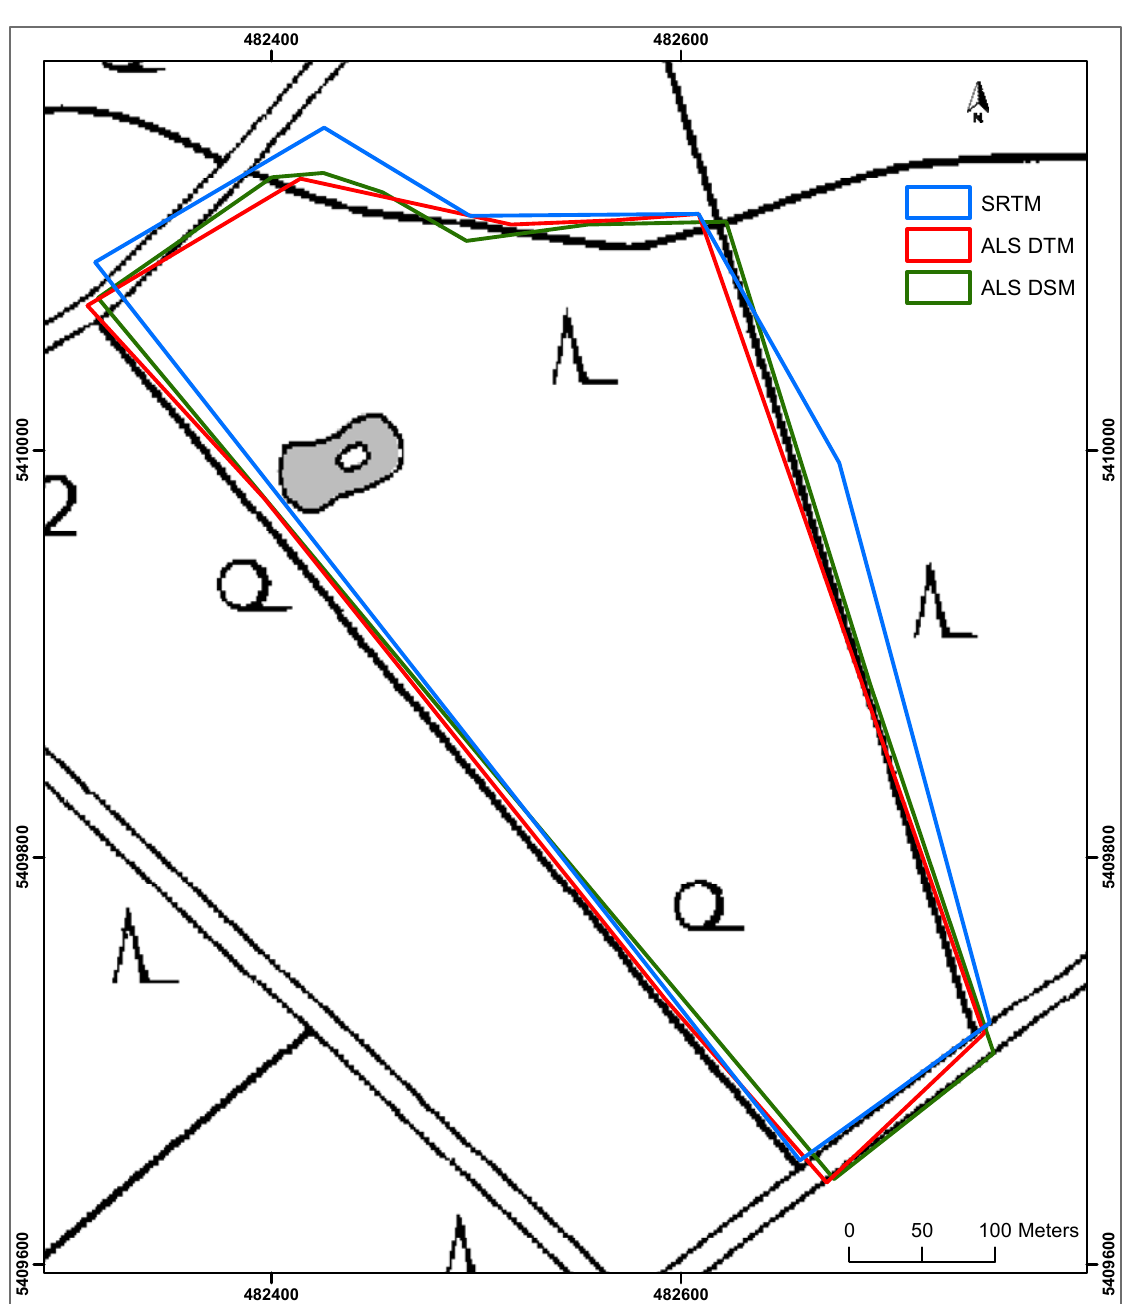
Figure 2. Boundary of a forest stand located in Pforzheim, digitized from three different orthorectified TerraSAR-X images in leaf-off conditions. The official digital topographic map is shown as reference in UTM coordinates (zone